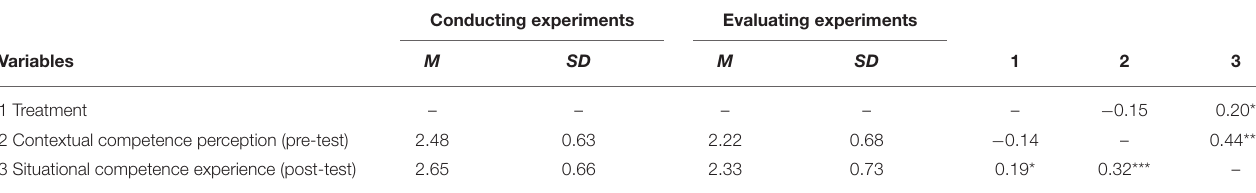
TABLE 2 | Descriptive statistics and correlations of the investigated variables regarding conducting (below the diagonal) and evaluating the experiments (above the diagonal). Conducting